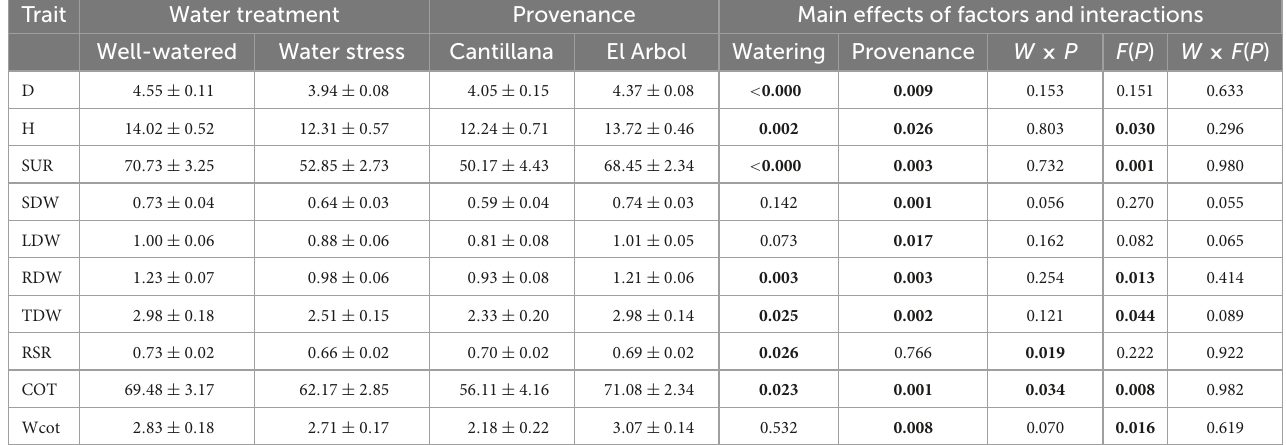
TABLE 3 Main effects in growth, survival, and biomass parameters tested through 2-Way ANOVA using watering treatment ( W ) and provenance ( P ) as fixed factors and family ( F ) as a random nested factor in provenance ( F ( P )). Trait